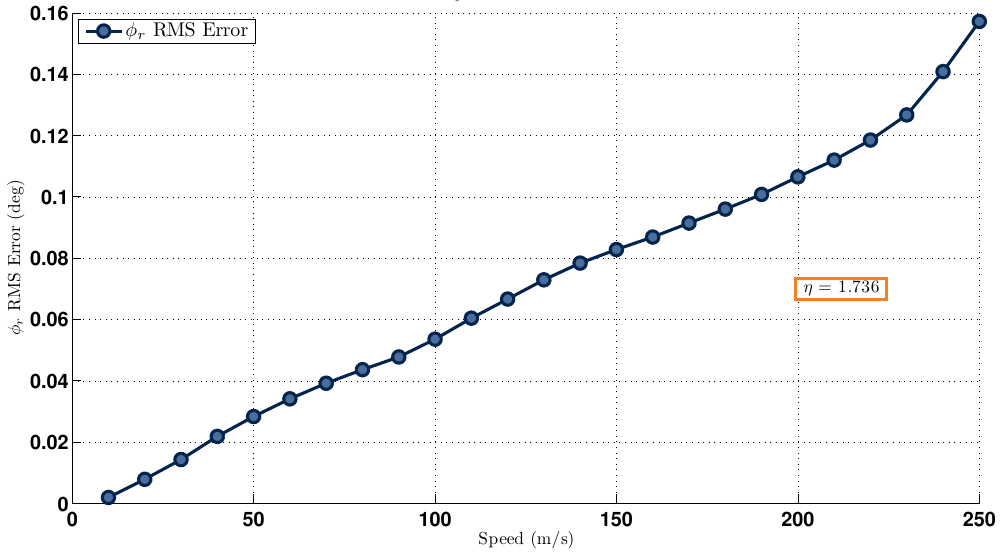
Figure 4. RMS error for DLC on a flat surface vs.